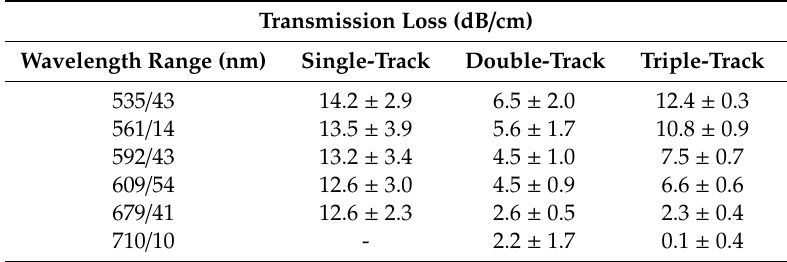
Figure 7. ( a ) Output intensity profile of a double-cored (blue) and triple-cored (red) waveguides (wgs), at 535 / 43 nm spectral band. Waveguide outputs are displayed in the image inset; ( b ) Transmission loss in dB / cm as a function of wavelength for simple (green), double- (blue) and triple- (red) track waveguides. Dot lines indicate the linear fit with − 4.0 slope, for both double- and triple-track waveguides, typical of pure Rayleigh scattering. Table 1. Summary of transmission loss for the di ff erent waveguide types in di ff erent wavelength ranges in dB /